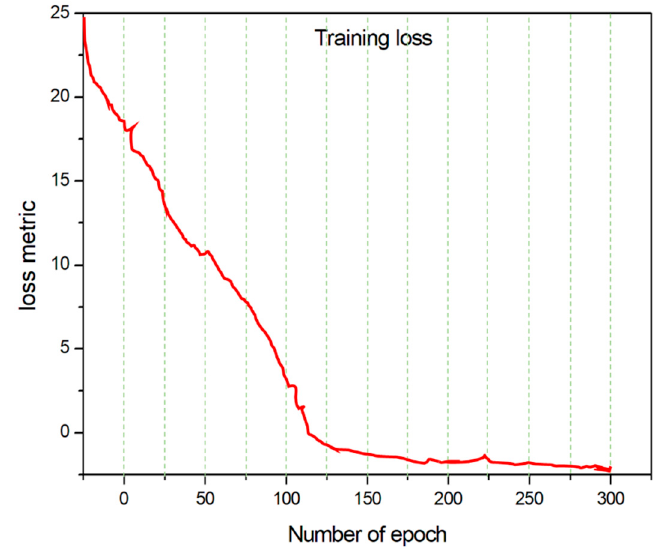
Figure 4. Number of epochs versus training loss (e.g., 300 rounds).